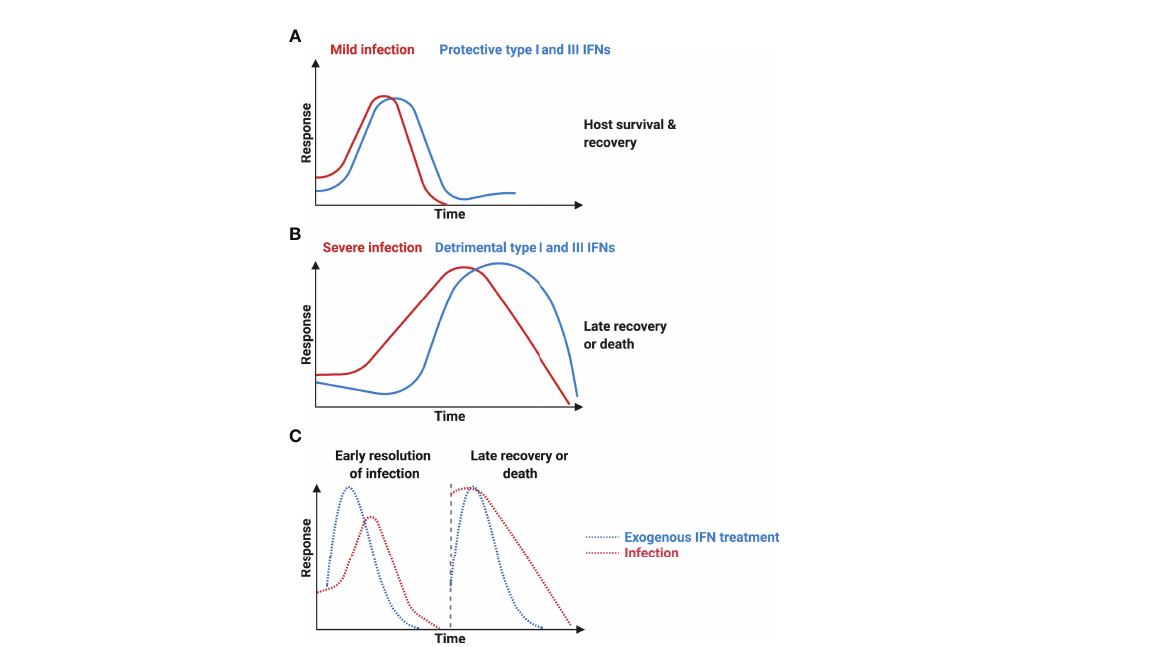
FIGURE 3 | Protective interferons and interferonopathy. (A) Mild SARS-CoV infection is associated with early productions of type I interferons (IFNs) and resolution of viral infection. (B) Severe infection is accompanied with delayed but sustained type I IFN expressions and is associated with more severe diseases with increased